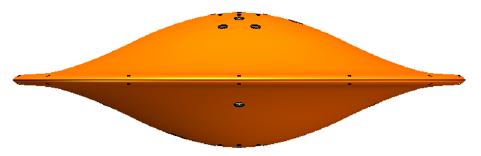
Figure 1. Full-wing body of a disc-type underwater glider (DTUG).